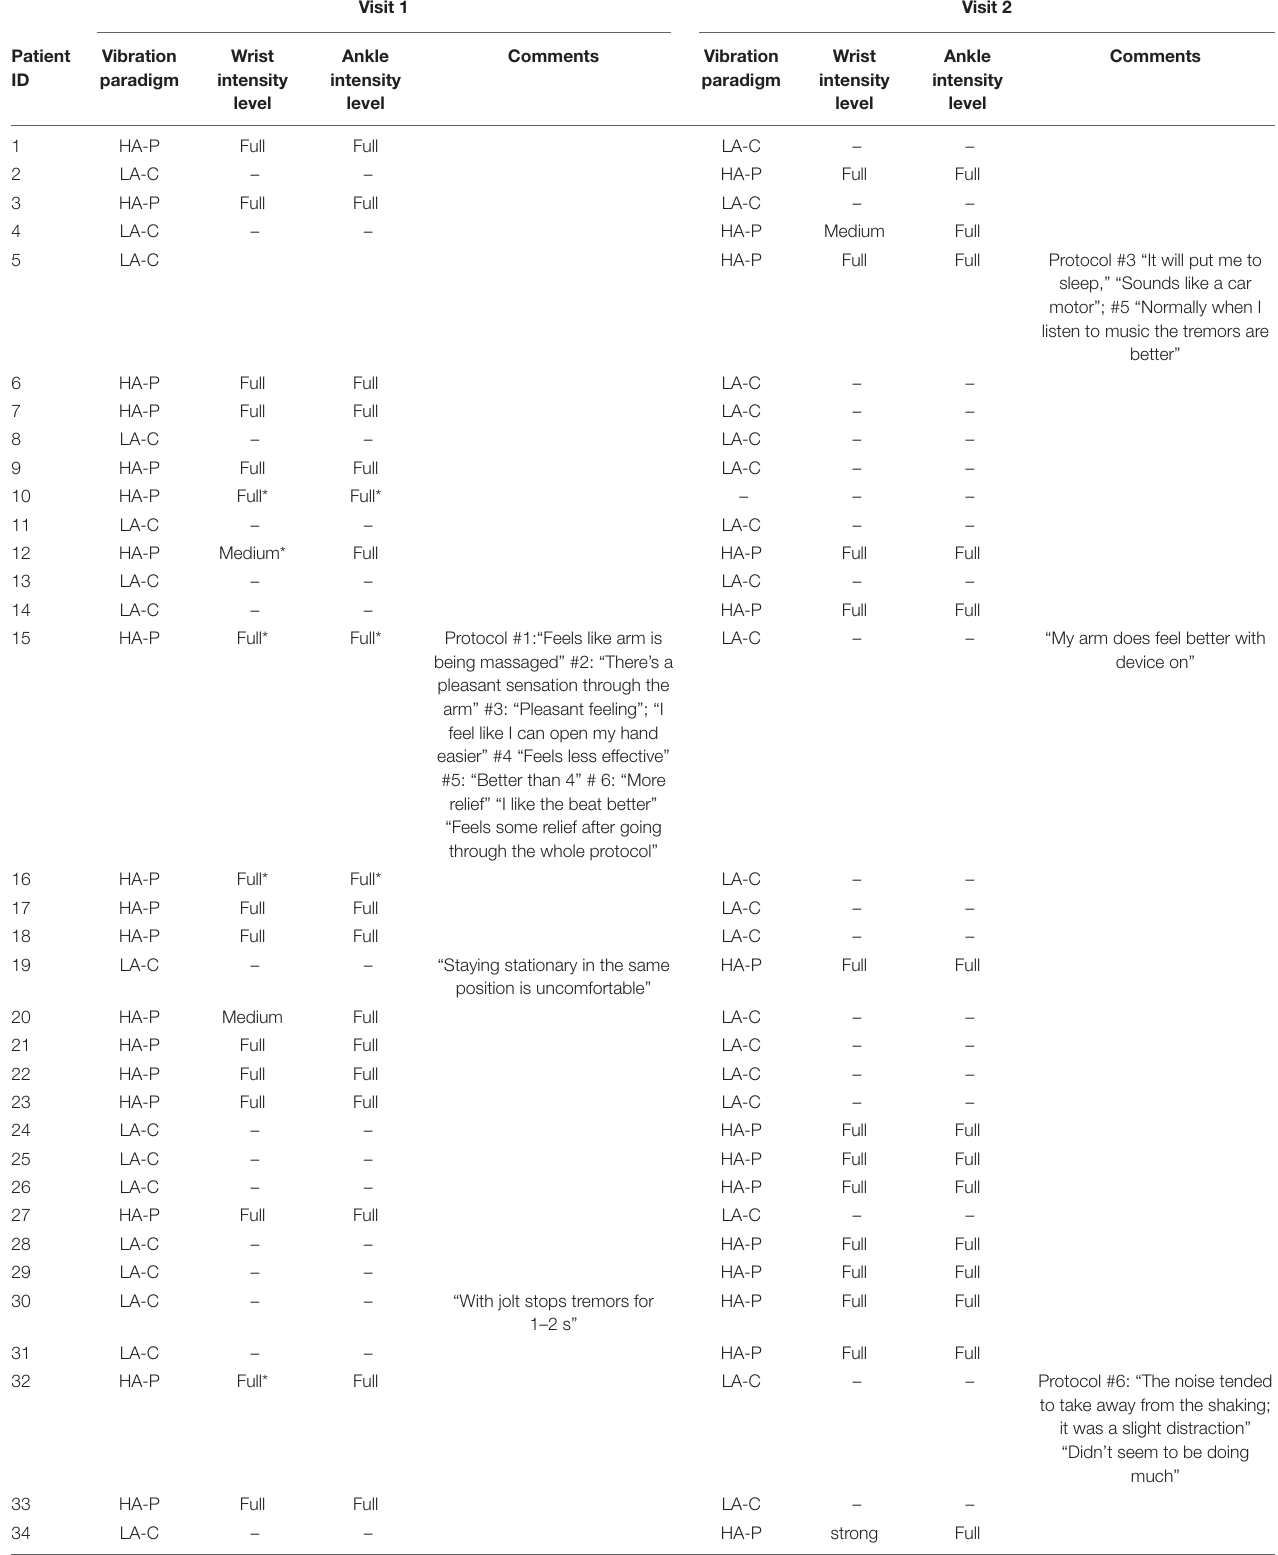
TABLE 1 | Vibration paradigm, intensity, and comments during study visits.